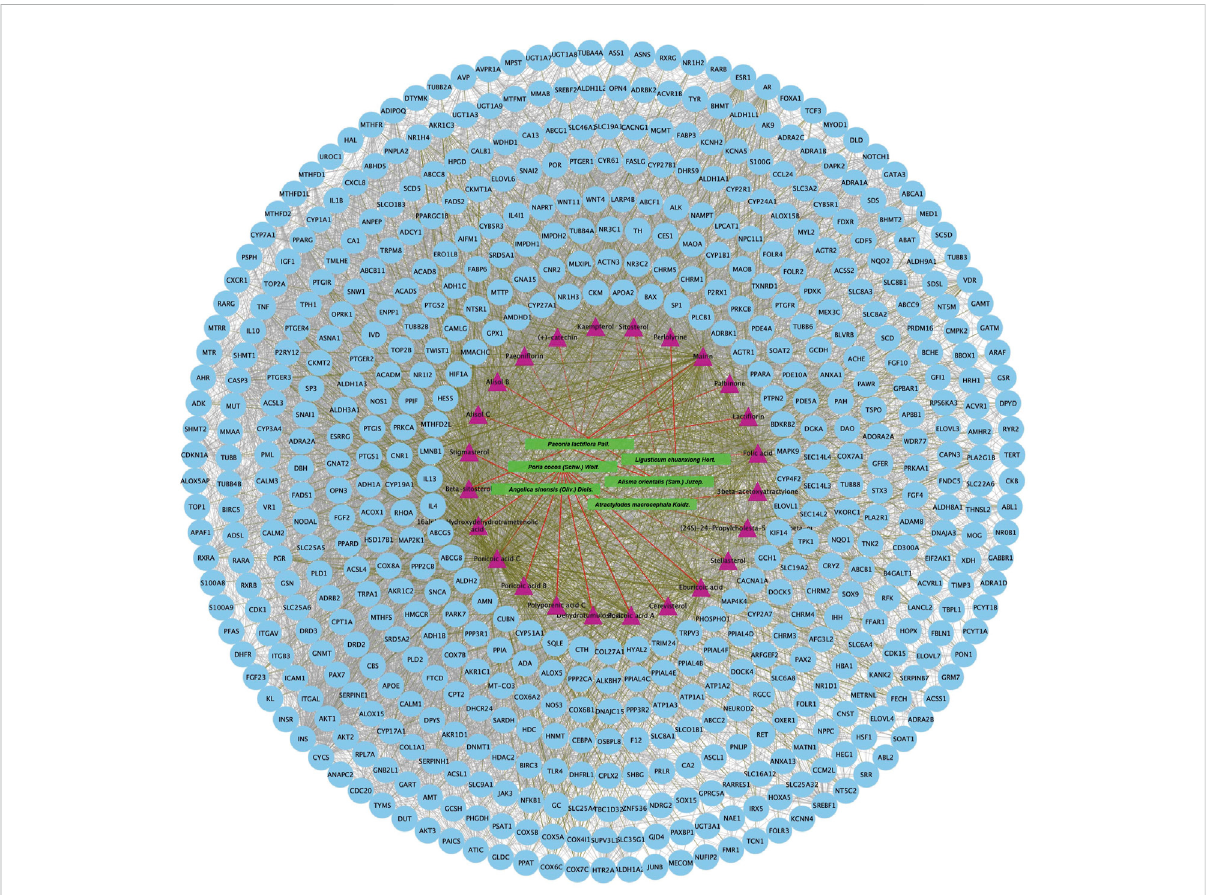
FIGURE 5 Protein-proteininteractionnetworkofproteinstargetedby24activechemicalingredientsofDSS.ThegreenrectanglesrepresentherbsofDSS, the purple triangles represent screened active ingredients of these herbs, and the blue circles represent their targets. The red lines represent the interactions between herbs and the chemical ingredients, the grass green lines represent the interactions between ingredients and the predicted targets, while the protein-protein interactions were represented as prey